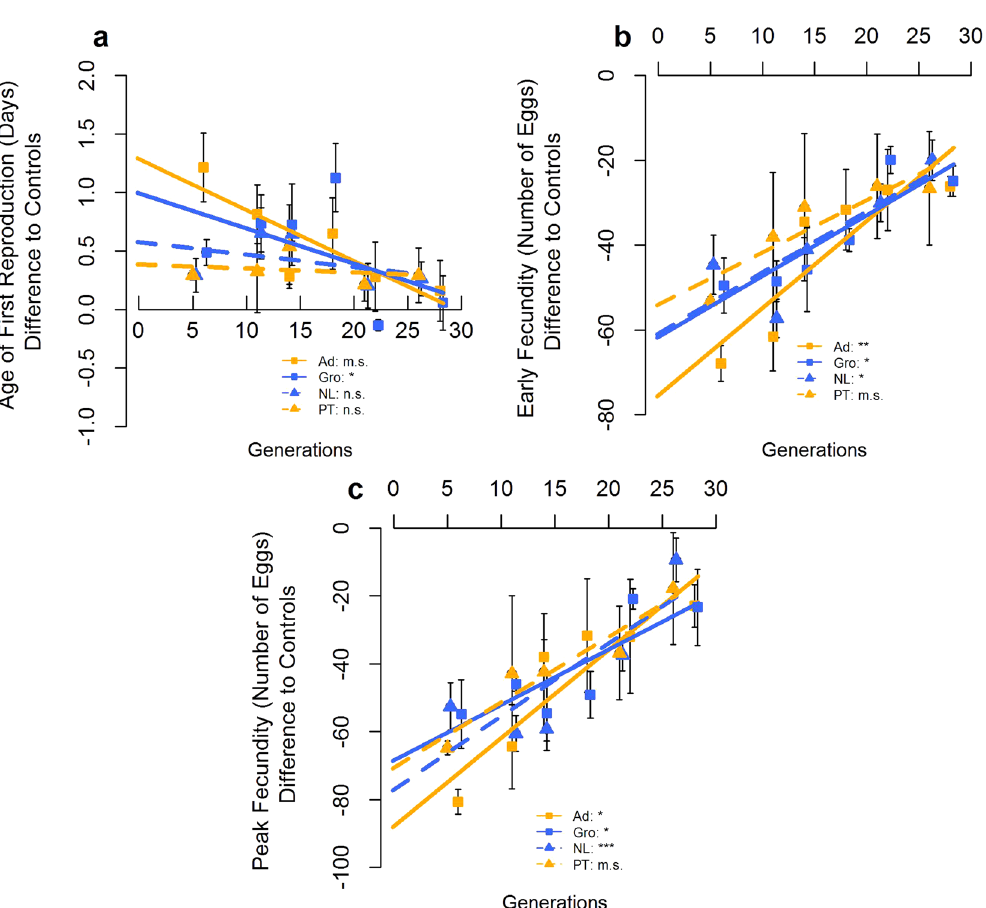
Figure 1. Evolutionary trajectories for the fecundity-related traits analysed. Age of First Reproduction ( a ), Early Fecundity ( b ) and Peak Fecundity ( c ) are presented for each foundation, as well as the corresponding linear regression models. Values shown correspond to differences between experimental populations and the average performance of the control (TA) populations assayed in synchrony at each generation. Error bars correspond to variation between replicate populations of each foundation. Significance levels of linear regression models: p > 0.1 n.s.; 0.1 > p > 0.05 m.s.; 0.05 > * p > 0.01; 0.01 > ** p > 0.001; *** p < 0.001. Populations from Portugal (Ad and PT) – Orange; Populations from Netherlands (Gro and NL) – Blue; 2010 Populations (Ad and Gro) - Squares, solid line; 2013 Populations (PT and NL) – Triangles, dashed